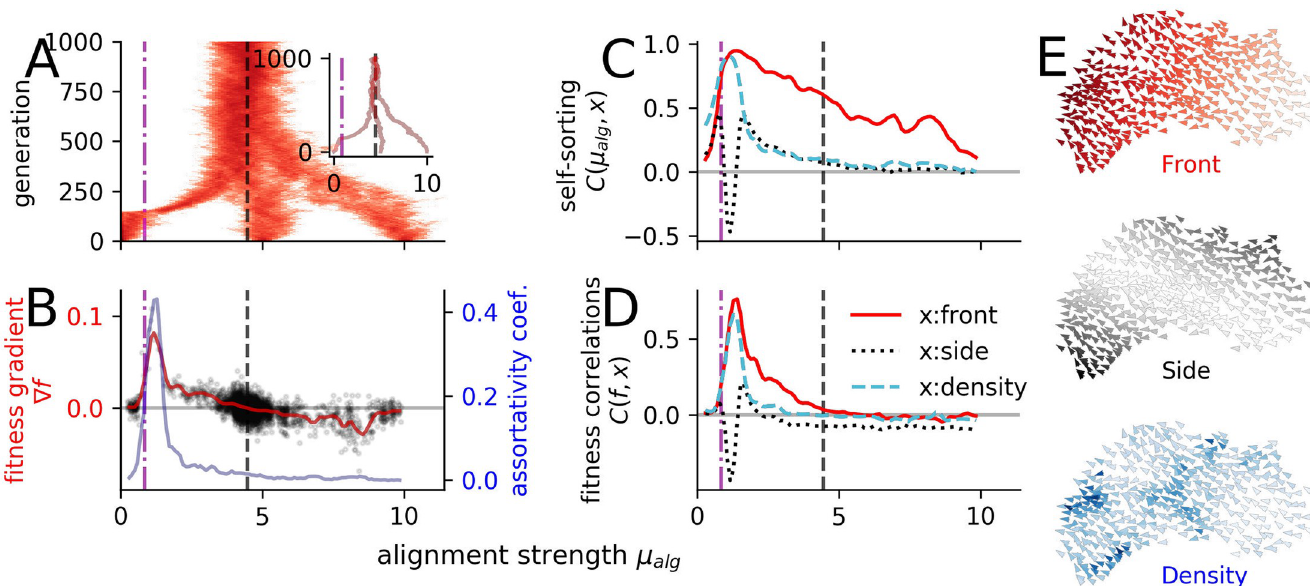
Fig 3. Evolution under predation. ( A ) Overlay of three independent evolutionary runs starting at h μ alg i = [0, 5, 10] over 1000 generations. The behavioral phenotype is determined only by the alignment strength as the evolving parameter. The predator attacks from random initial directions for T = 120. The inset shows the simu evolution of the population mean alignment parameter h μ i of the three different evolutionary runs. ( B ) Assortativity coefficient ( blue line ) and smoothed fitness alg gradient r f ( red line ). The evolutionary stable state is defined by the zero crossing of the fitness gradient and represented as a vertical dashed black line. Black dots are the non-averaged fitness gradients for each generation (see Methods). ( C ) Self-sorting measured as correlation C ( μ , x ) between the individual alignment strength μ alg alg and variables quantifying its (spatial) location within the school: front-back position ( red ) and side-center position (black) and local density ( blue ). ( D ) Correlation C ( f , x ) of individual fitness with the average relative spatial positions. ( E ) Simulation snapshot illustrating the location variables: front-back position ( red ) and side-center position (black) and local density ( blue ). In all panels: the vertical dash-dotted magenta line marks the order-disorder transition and the vertical dashed black line the evolutionary stable